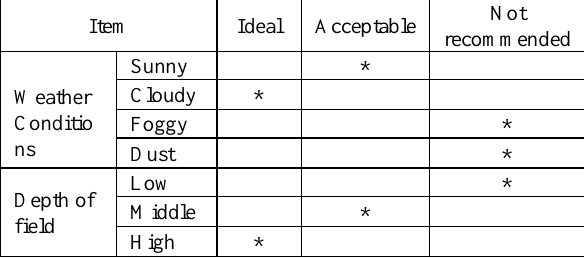
Figure 2 . Example of the re-named